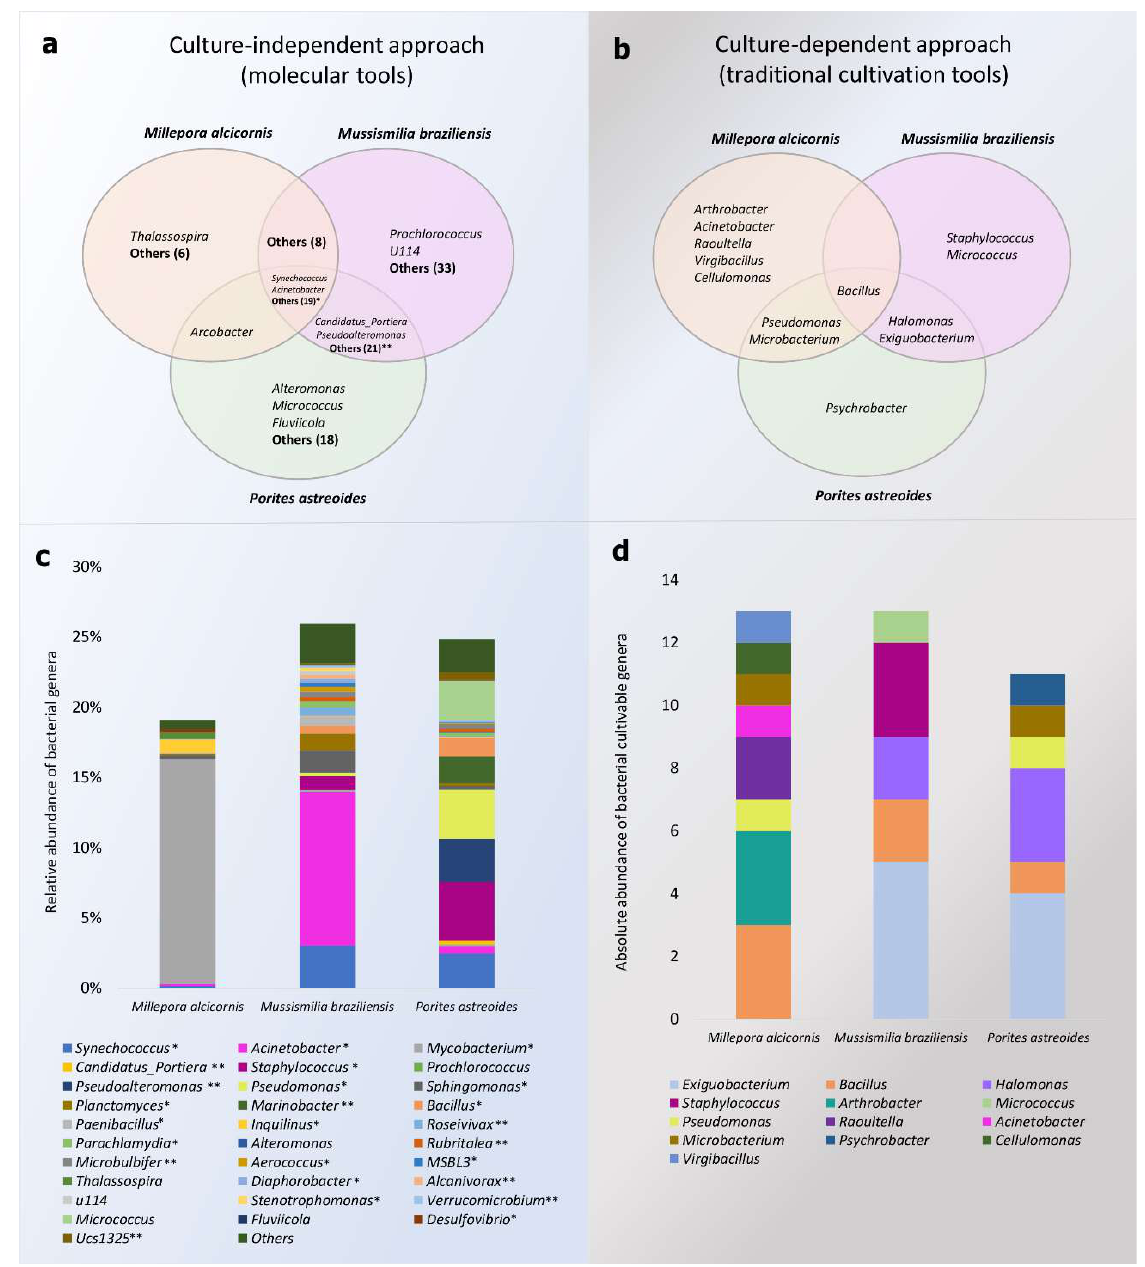
Figure 3. ( a ) Venn diagram showing the bacterial genera obtained from culture-independent methods. ( b ) Venn diagram showing the bacterial genera obtained from culture-dependent methods. ( c ) Taxonomic classification and relative abundance of the bacterial genera from Ma, Mb, and P by molecular methods. ( d ) Absolute abundance of genera from Ma, Mb, and P by culture-dependent methods. * indicates the microbial genera shared by all coral samples in the list below the respective column; ** indicates the microbial genera shared by Mb and P in the list below the respective column in ( a ) and ( c ).